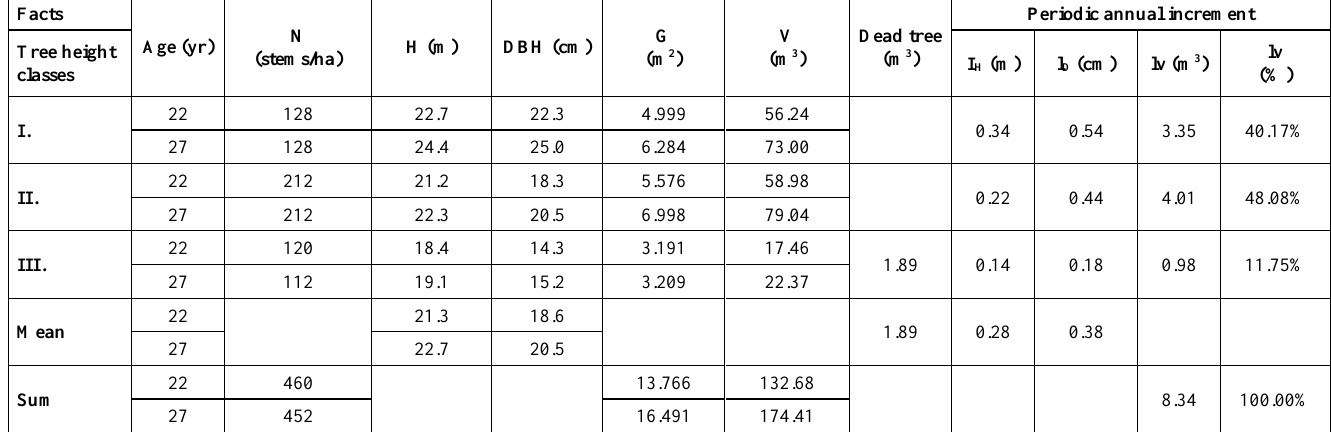
Table 1. Stand characteristics and periodic annual increments (Pusztavacs 215 E)